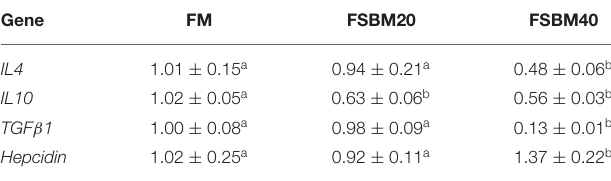
TABLE 8 | Effect of fermented soybean meal substitute for fish meal protein on the anti-inflammatory gene expression in hindgut of pearl gentian grouper ( n = 3).